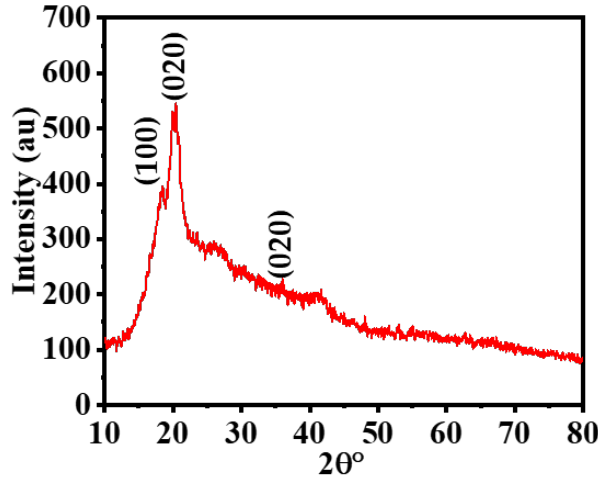
Figure 4. XRD results of Ni 75 Pd 25 @PVDF-HFP NFs membrane.